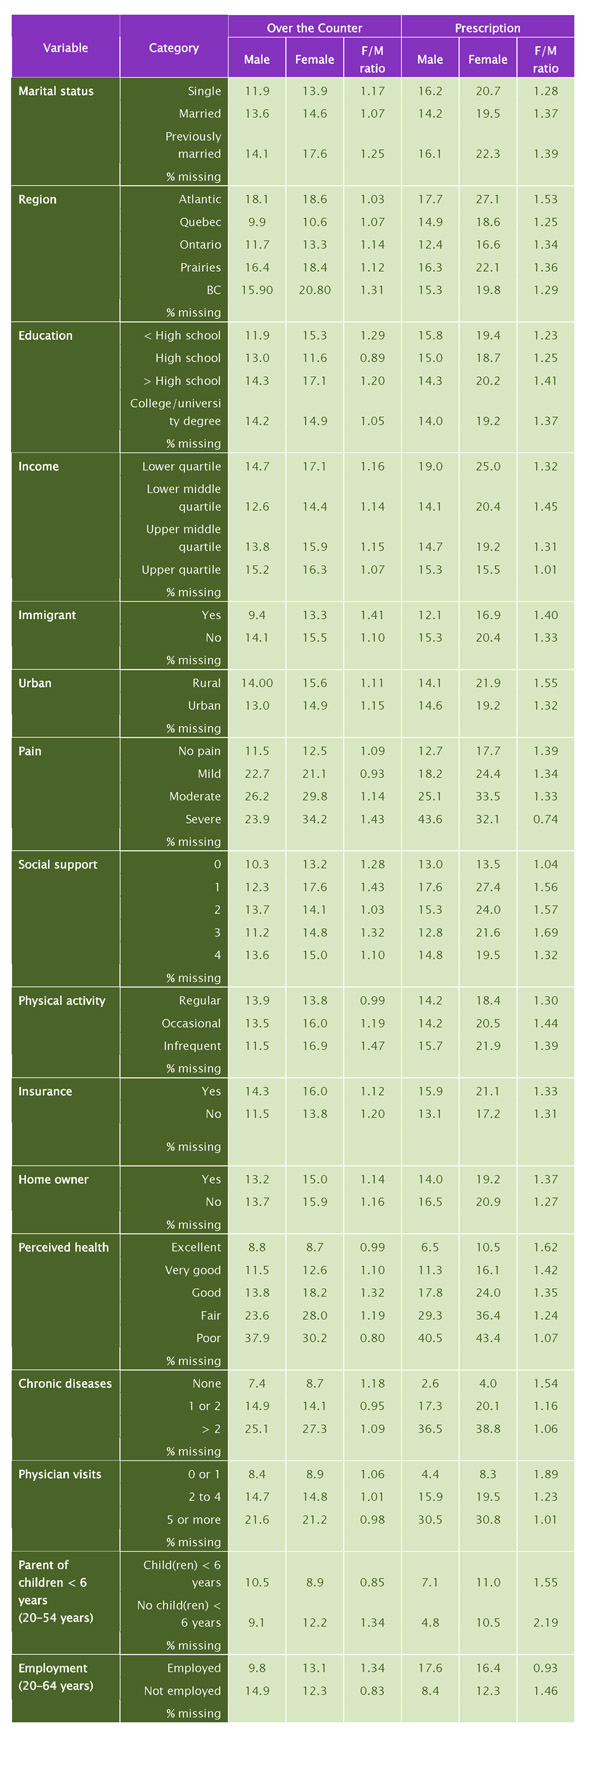
Proportion of Canadians 20+ Years Taking Medications by Potential Determinants, Sex and Type of Medication (Age-Adjusted to 1991 Canadian Population) Source: Statistics Canada, NPHS, 1996–1997